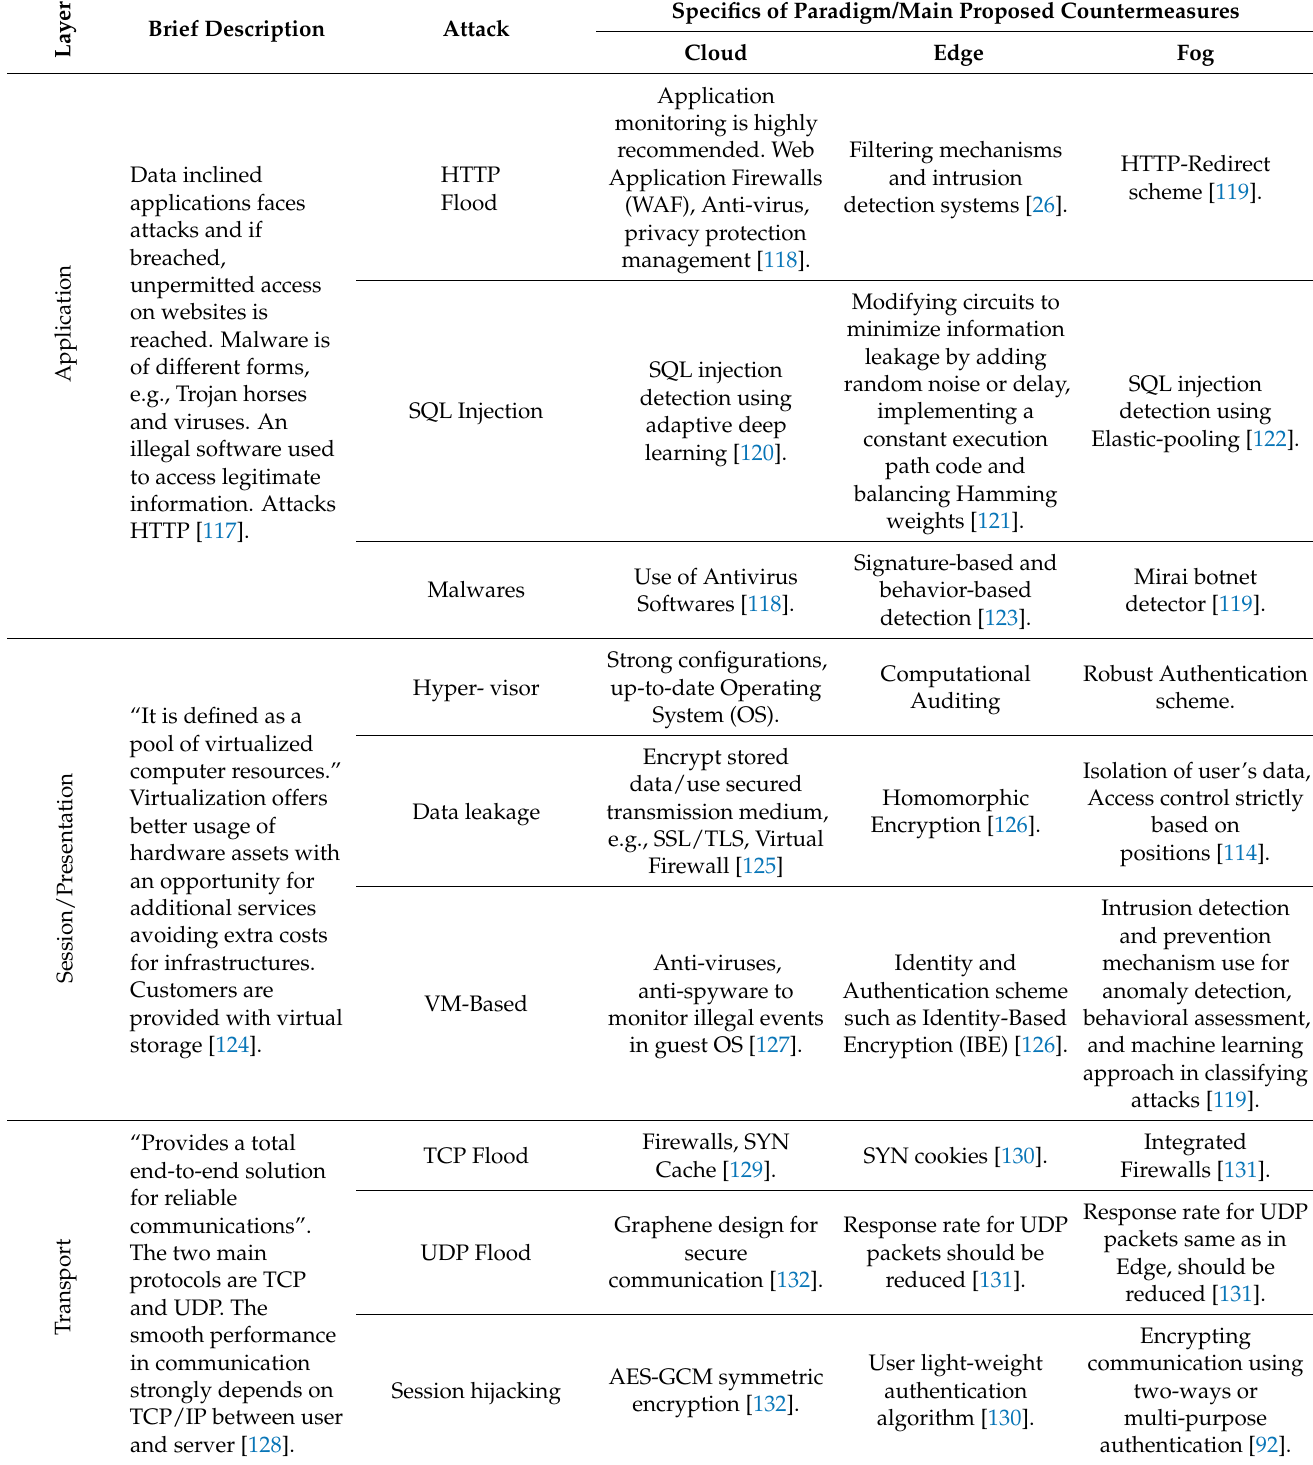
Table 2. Attack specifics of paradigms and suggested